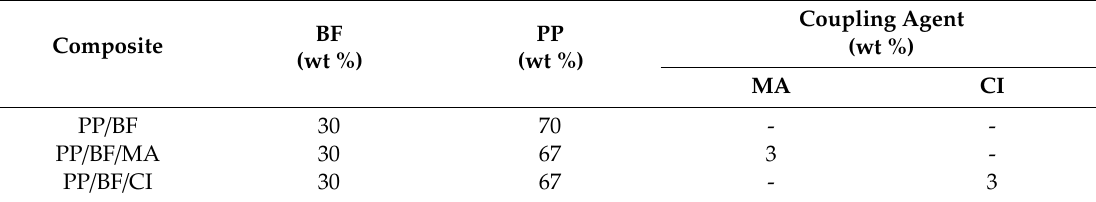
Table 1. Formulations of PP / BF composites without CA and with